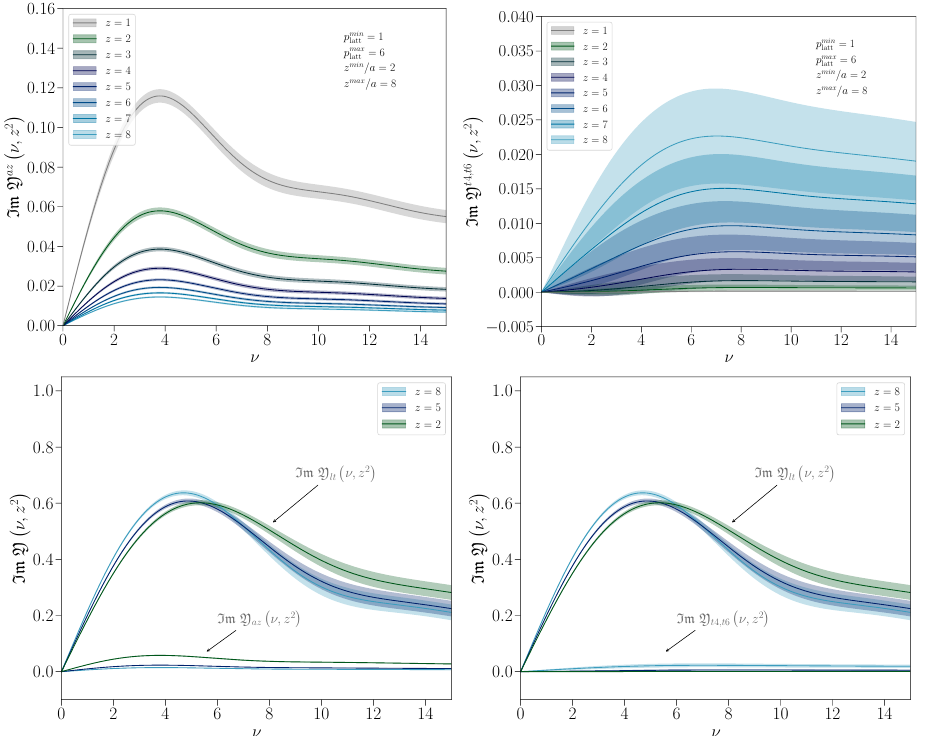
Figure 10 . (Upper left) Discretization and (Upper right) net higher-twist nuisance terms deter- mined from the fit in figure 8 shown for z/a ∈ [1 , 8] . The lower two panels compare each nuisance effect (discretization at the left and higher-twist at the right) on an absolute scale with the param- eterized leading-twist reduced pseudo-ITD Im Y presented in